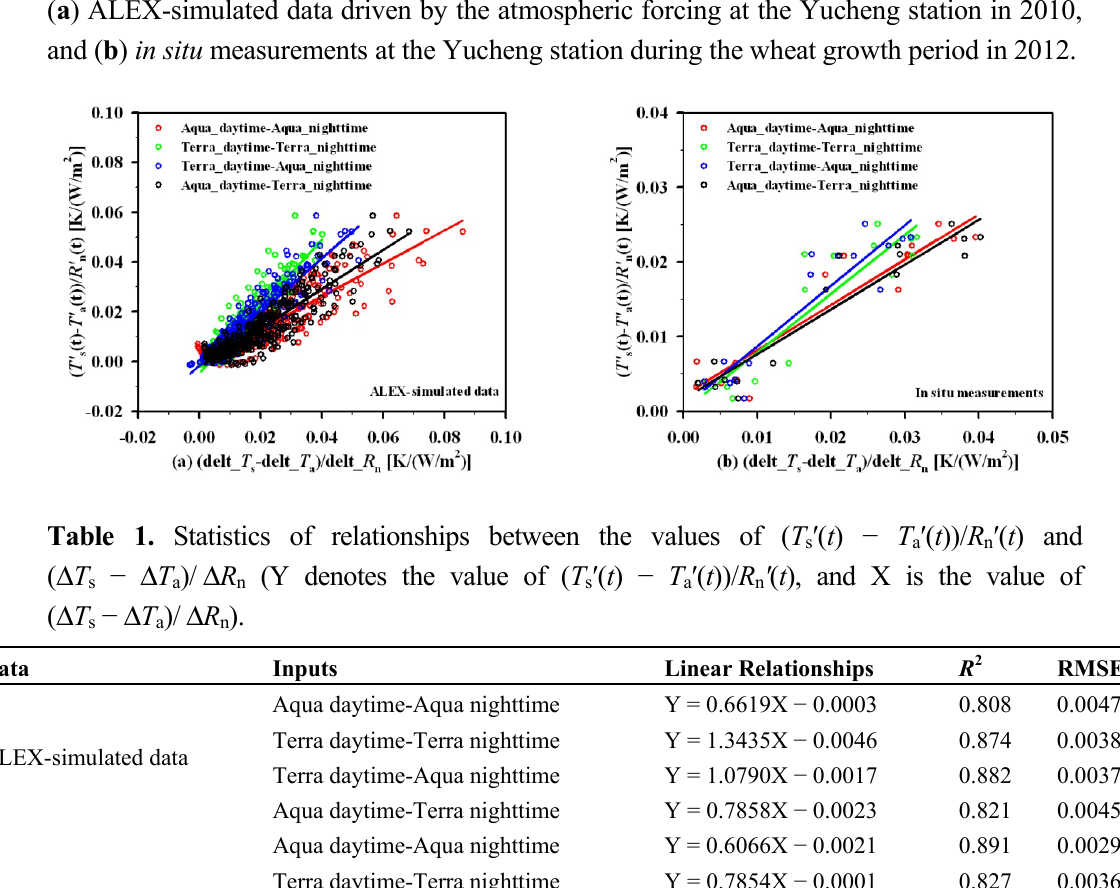
′ ( t ) − T ′ ( t ))/ R ′ ( t ) and ( Δ T − Δ T )/ Δ R for a n s a n s